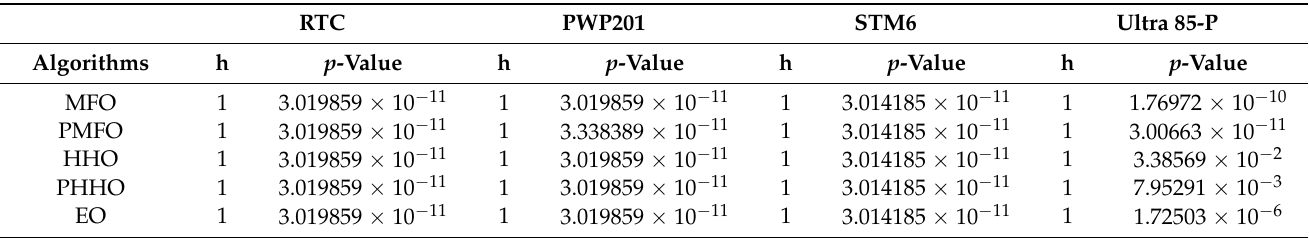
Table 12. Comparison between PEO with the others under the Mann – Whitney U test.